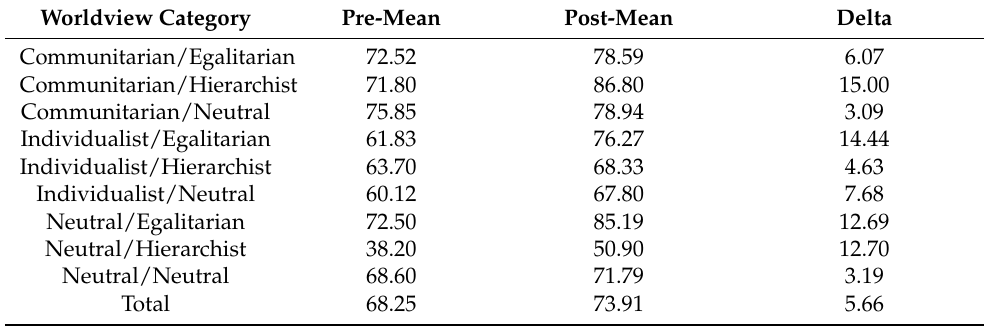
Table 6. Comparison of Worldview Category with Pre and Post-intervention Mean